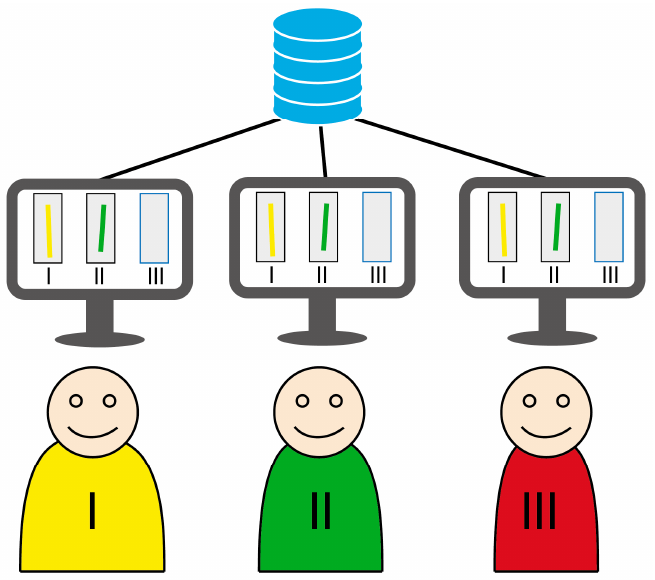
Figure 6. Use of the Multi-player Mode in a computerized adaptation of Asch conformity